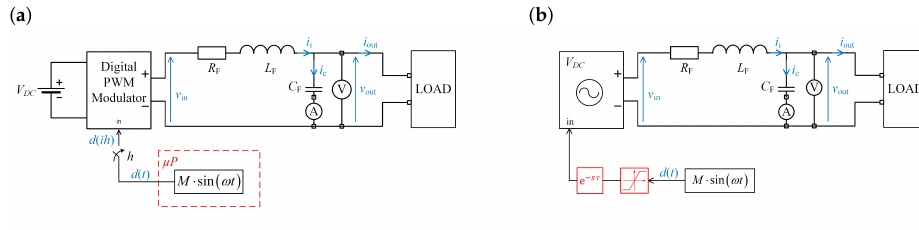
Figure 7. ( a ) Open loop PWM controlled system model, and ( b ) QCT model of the system in ( a